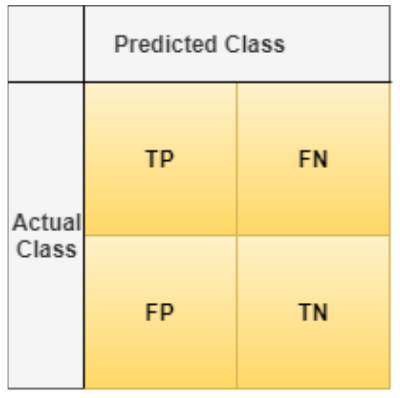
Figure 12. Sample confusion